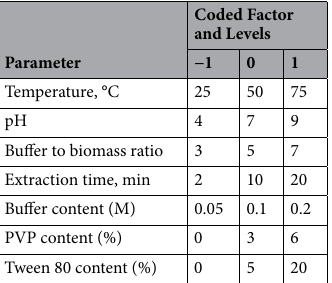
Table 4. Selection of parameters and their levels for RSM